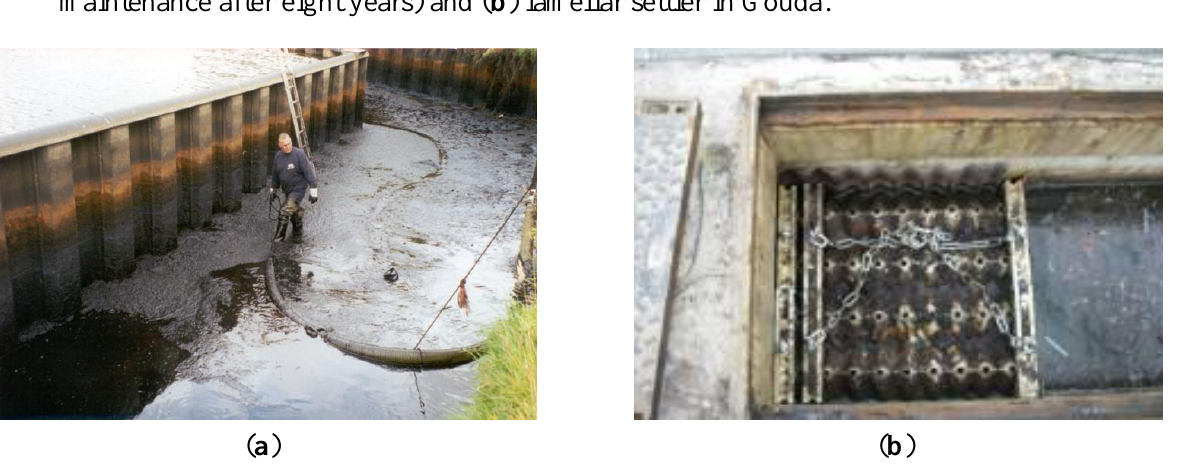
Figure 1. ( a ) Sediment basin in Amsterdam (sludge from stormwater system during maintenance after eight years) and ( b ) lamellar settler in